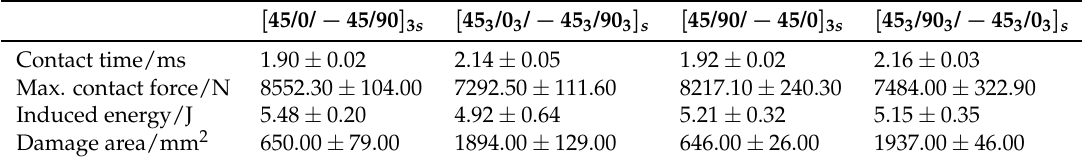
Table 2. Results of impact test and boundary